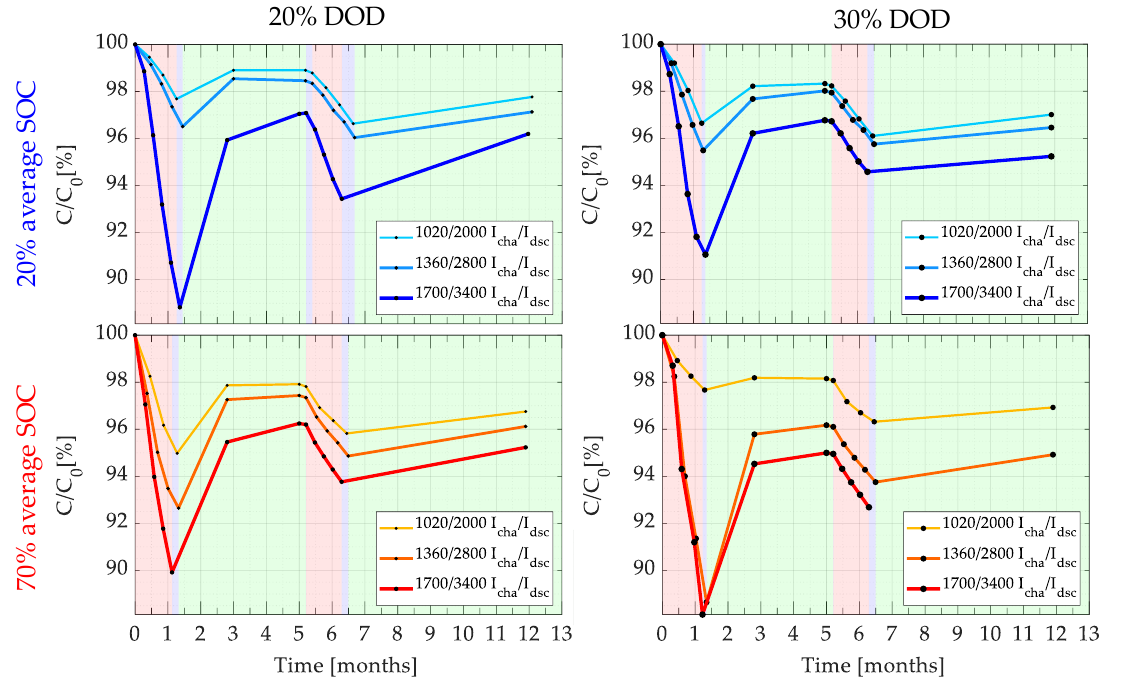
Figure 4. Capacity loss for cells cycled with charge/discharge currents in mA of 1020/2000, 1360/2800, and 1700/3400. The plots are arranged in a matrix with the average SOCs of 20% and 70% and DODs of 20% and 70%. Cycling, transition, and resting phases are depicted with red, blue, and green backgrounds, correspondingly.